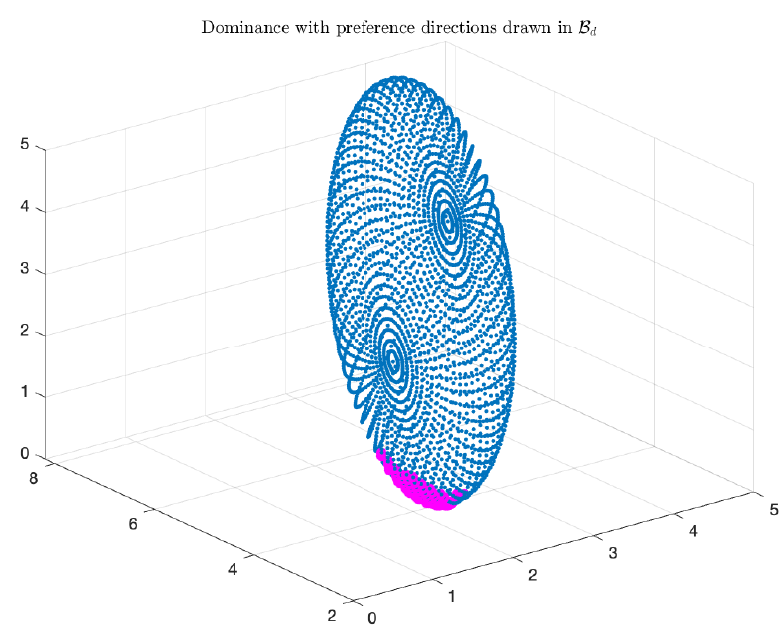
Figure 7. 3D deformed sphere (blue points) resulting from preferences and Pareto front approxima- tion (in magenta) drawn in B d